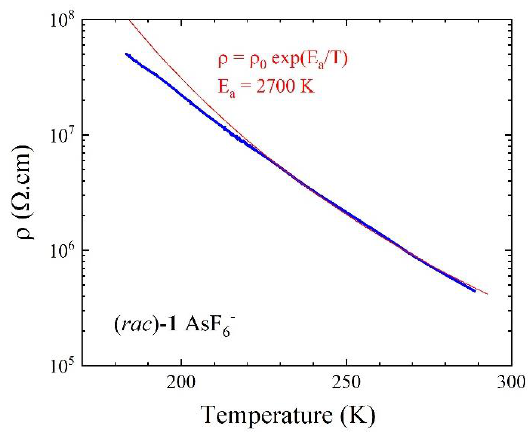
Figure 9. Temperature dependence of the electrical resistivity (blue line) for a single crystal of the radical cation salt of (rac)- 1 with AsF 6 – . The red line is the fit to the data with a law of the type ρ = ρ 0 exp(E a